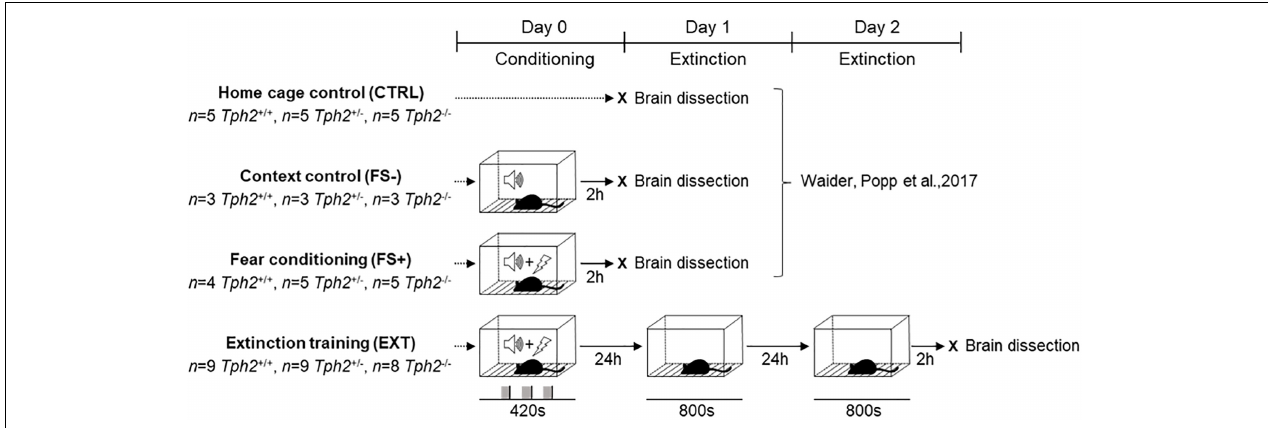
FIGURE 1 | Experimental design for c-Fos immunoreactivity after fear conditioning and context-dependent extinction. Tph2 + / + , Tph2 + / − , and Tph2 − / − mice were exposed to a fear conditioning (FC) protocol and subsequently subjected to a context-dependent extinction protocol. On day 0 mice were placed in the conditioning chamber receiving three pairings of a 20 s tone cue co-terminating with a 2 s foot shock. On day 1 and again on day 2, mice were tested for recall and extinction of context-dependent fear memory using an extinction session consisting of re-exposing the animals to the conditioning context for 800 s without negative reinforcement. Two hours after extinction on day 2, brains were dissected for hippocampal c-Fos expression analysis (EXT) and compared to controls that were left undisturbed in the home cage (CTRL), controls that were exposed to the FC context and tone cue without foot shocks (FS–), and mice that underwent FC with tone-signaled foot shocks (FS+) with brain dissection 2 h after the test (Waider et al.,